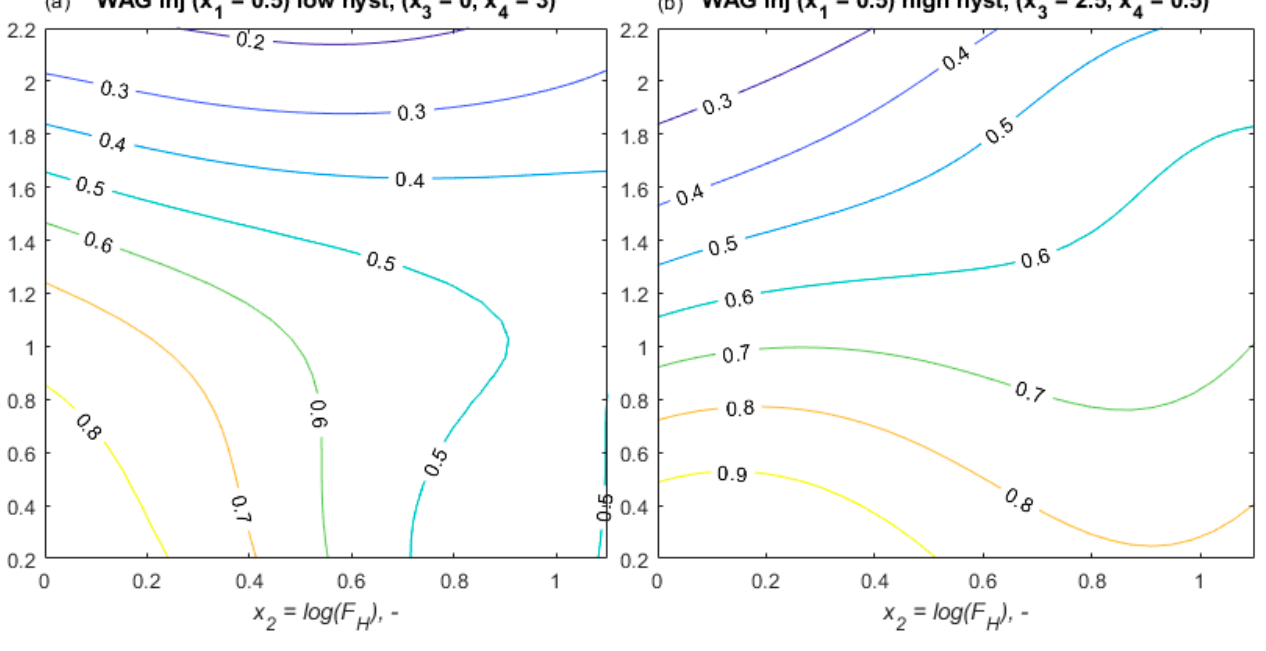
Figure 10. Contour plots of recovery factor RF plotted against 𝑥 (cid:2870) (cid:3404) log(cid:4666)𝐹 (cid:3009) (cid:4667) and 𝑥 (cid:2873) (cid:3404) 𝑙𝑜𝑔(cid:3435)𝑀 (cid:3034)(cid:3042)∗ (cid:3439) . The latter represents variation in oil viscosity, which affects all of x 5 , x 6 , x 7 , x 8 . The cases are for WAG injection with r w = 0.5 and either low ( a ) or high ( b ) hysteresis. See all input values in Table 5.